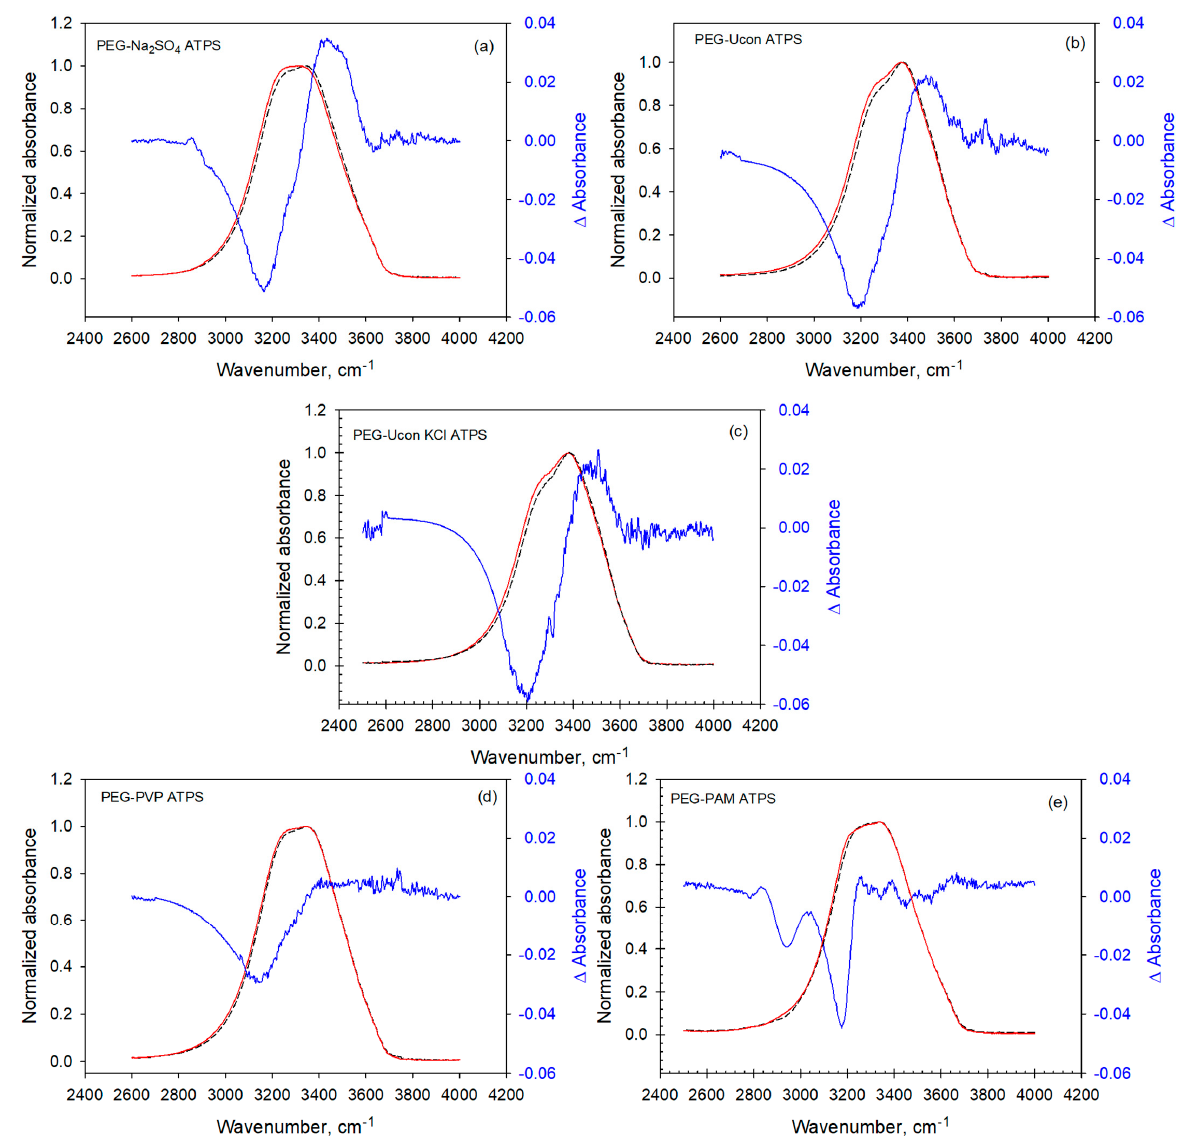
Figure 2. ( a – e ) ATR-FTIR spectra of the OH-stretch bands of water in the coexisting phases of ATPSs show the differences between the spectra. Top phase—dashed black line; bottom phase—solid red line; difference (right ordinate) between the spectra—solid blue line, calculated as the difference between the spectrum of the top phase minus the spectrum of the bottom phase. Figure 4a,b shows the estimated relative percentage area under each fitted Gaussian curve for each component as the function of the solute concentration with raw data in the Supplementary Material, Table S2.